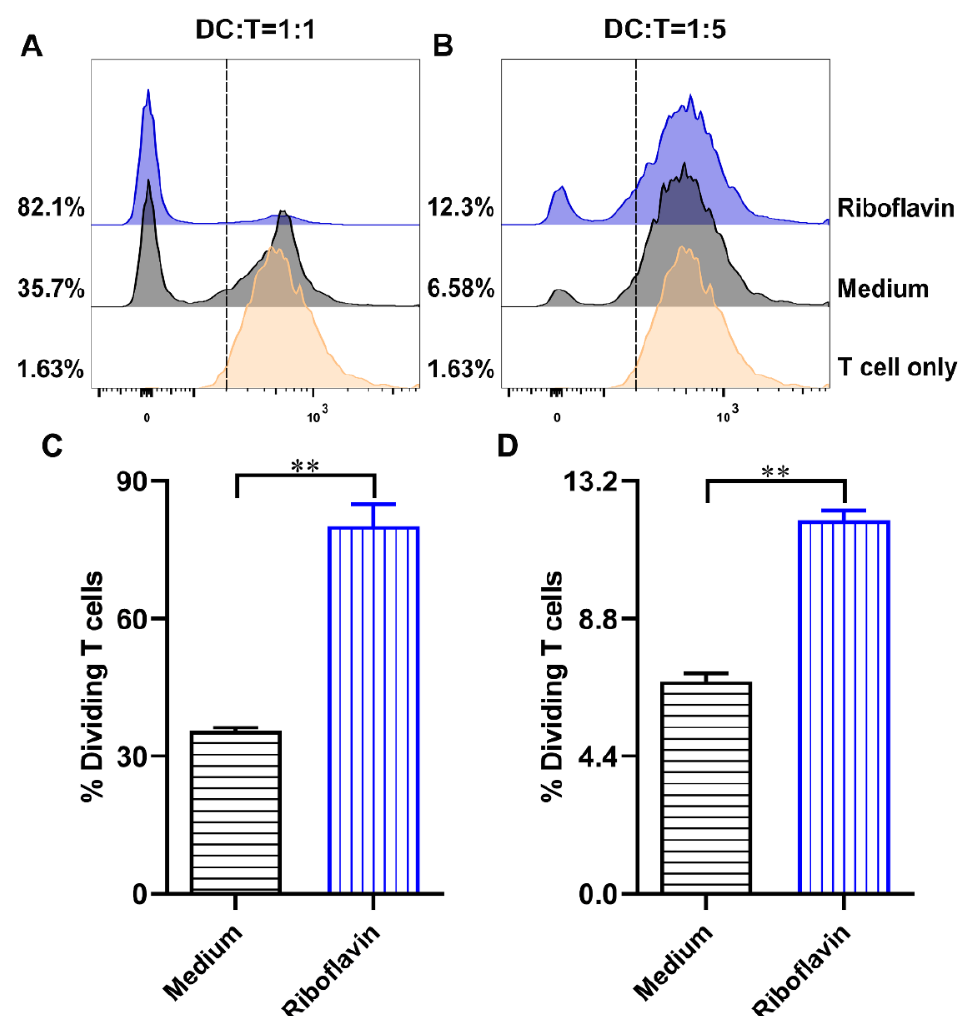
Figure 7. Riboflavin-induced DCs promote the proliferation of allogeneic CD4 + T cells. DCs were incubated with riboflavin (40 μ M) for 24 h and then cocultured with CFSE-labeled CD4 + T cells in two graded cell numbers (DC/T-cell ratios: 1:1 ( A ) and 1:5 ( B )). After 5 days, the proliferation of CD4 + T cells was detected via FCM. ( C , D ) The percentage values are presented as the mean ± SD. Results are from one representative experiment out of three performed. Unpaired Student’s two-sided t -tests were employed to determine the differences between the two groups; ** p < 0.01.